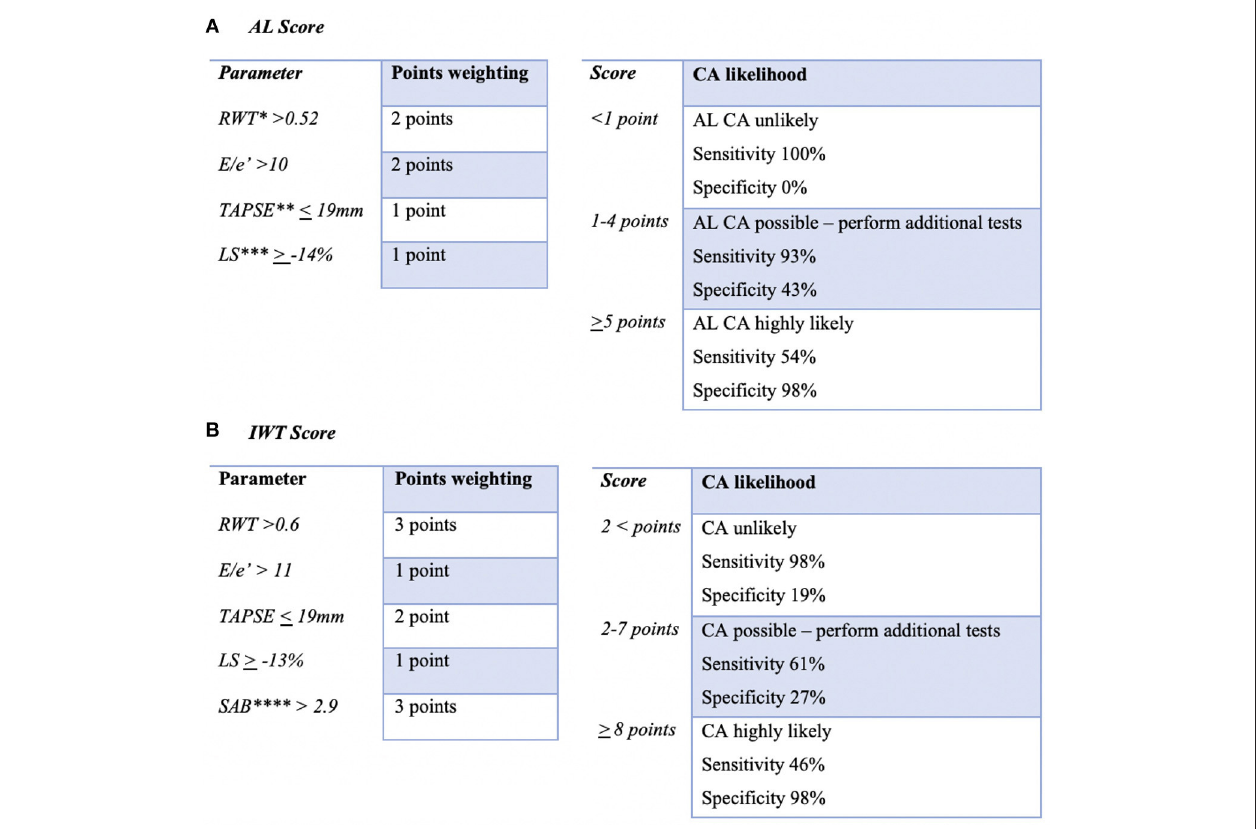
FIGURE 2 | Adaptation of echocardiographic scoring system proposed by Boldrini et al. Two scoring systems were proposed for the evaluation of the possibility of cardiac amyloidosis depending on the clinical scenario. The first being confirming/excluding cardiac involvement in patients with systemic AL amyloidosis (A) , the second being confirming/excluding cardiac amyloidosis in patients with increased LV wall thickness (IWT) (B) (35). One could consider the variables used in this scoring systems as echocardiographic “red flags” that would raise suspicion of CA to the sonographer/scanner. *RWT, relative wall thickness; **TAPSE, tricuspid annular plane systolic excursion; ***LS, longitudinal strain; ****SAB, systolic apex to base ratio.